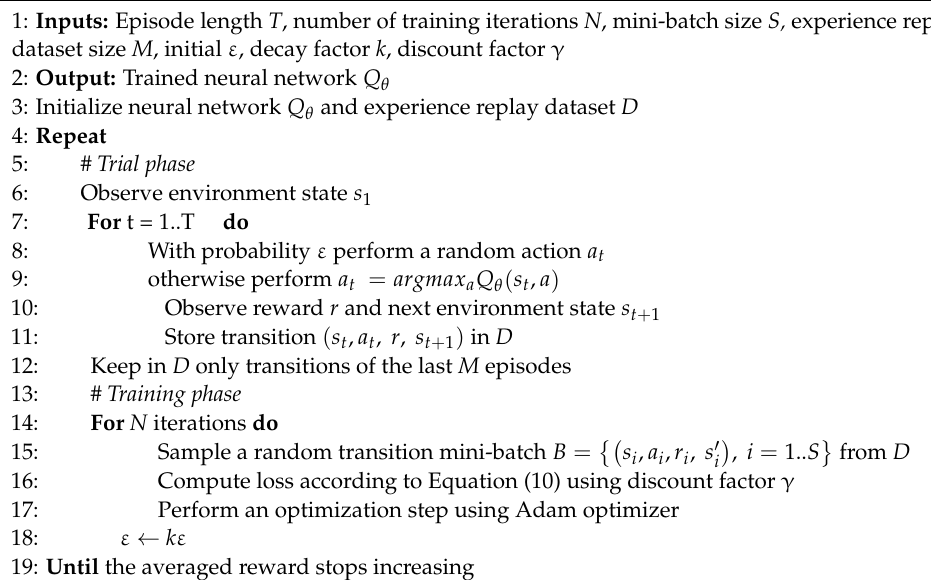
Algorithm 1: Deep Q-Learning